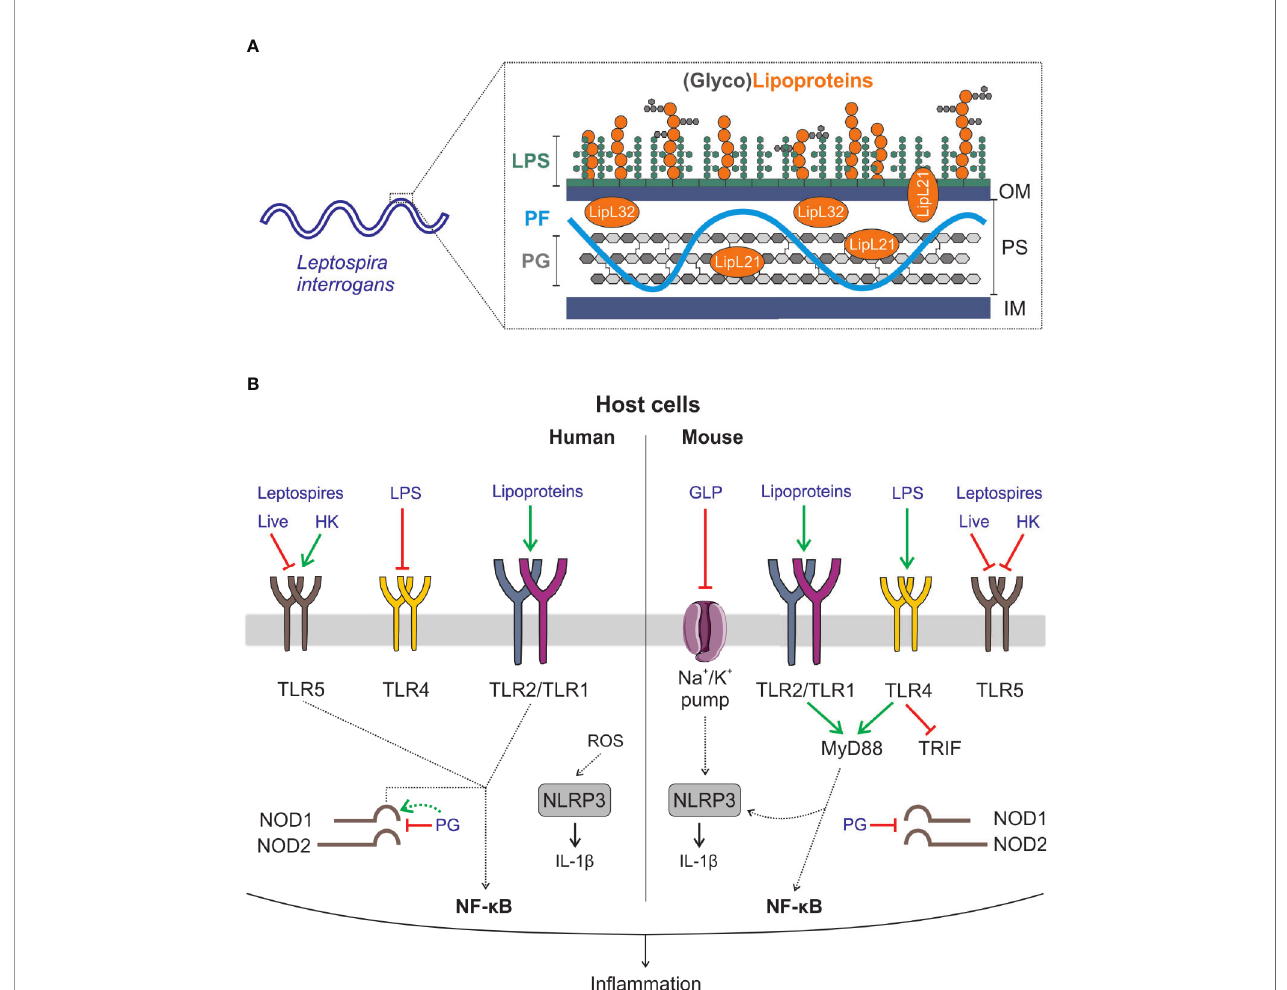
FIGURE 4 | Interaction of Leptospira interrogans with the innate immune system. (A) L. interrogans are diderm bacteria. Their cell wall is composed of an inner membrane (IM) and an outer membrane (OM) containing lipopolysaccharide (LPS). In between the membranes, the periplasmic space (PS) contains the peptidoglycan (PG) layer, the periplasmic fl agella (PF) that extends from each pole of the cell inside the PS and lipoproteins such as LipL32. Notably, leptospires contain in their OM a broad repertoire of lipoproteins and a glycolipoprotein (GLP) (111). (B) Host cells have a variety of mechanisms to detect microbes. One of them involves a subset of receptors collectively known as pattern recognition receptors (PRRs) that sense conserved and ubiquitously expressed microbial components. The latter are known as microbial-associated molecular patterns (MAMPs). Recognition of MAMPs by PRRs triggers the immune response. In blue, leptospiral MAMPs and MAMP sensing in human (left side panel) and mouse (right side panel) cells are shown. TLR2 is the main receptor for sensing leptospires, which is common in humans and mice. TLR2 heterodimerizes with TLR1 and detects triacylated lipoproteins. A major difference between sensitive humans and resistant mice is the speci fi c sensing of the leptospiral LPS (113), a major leptospiral MAMP and virulence factor (34). Mouse TLR4 but not human TLR4 is able to detect it (114 – 116). However, the stimulation of mouse TLR4 by leptospiral LPS is only partial, since only the MyD88 pathway but not the TRIF pathway is activated. This results in only minimal production of antimicrobial components such as nitric oxide (117). Due to the presence of PF in leptospires, live leptospires also escape TLR5 recognition. However, once leptospires are killed by antimicrobial peptides that expose PF, leptospiral fl agellins are recognized by human (and bovine) TLR5 but not by mouse TLR5 (118). Leptospires have been described to induce activation of the NLRP3 in fl ammasome in both humans and mice. In mice, activation of the in fl ammasome requires 2-step signaling involving LPS and lipoprotein signaling through TLR4 and TLR2, respectively, in combination with the downregulation of a Na/K pump (a danger signal) by GLP (119). In humans, NLRP3 activation is mediated by bacteria-induced ROS (120). Finally, PG from leptospires escapes host recognition by NOD1 and NOD2 due to the lipoprotein LipL21, which is tightly attached to the PG. In addition, human but not murine NOD1 can detect leptospiral PG in the absence of LipL21